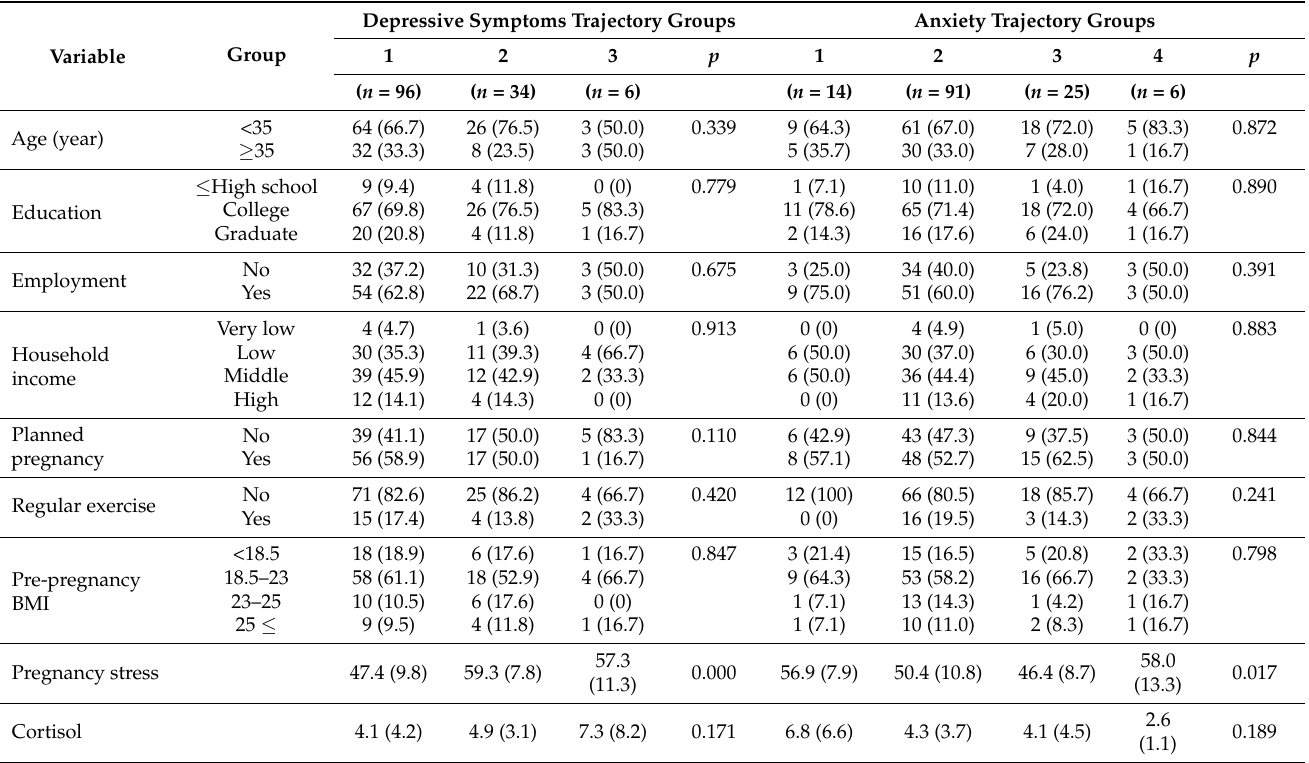
Table 3. Sociodemographic characteristics and health behaviors by trajectory groups of depressive symptoms and anxiety ( n = 136) [ n (%)/Mean (SD)].